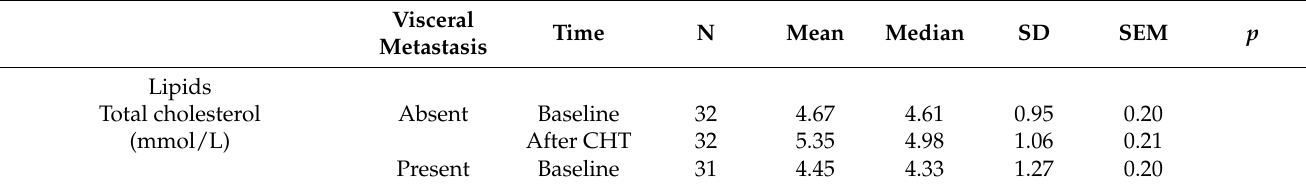
Table 3. Plasma lipids, antioxidants, index CoQ 10-TOTAL /lipids, and oxidative stress baseline vs. after two courses of chemotherapy in metastatic urothelial carcinoma (mUC) patients—a subgroup analysis by visceral metastases. N: number of patients; SD: standard deviation; SEM: standard